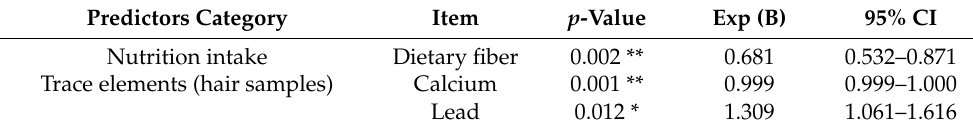
Table 5. Predictors of mortality at 5-year